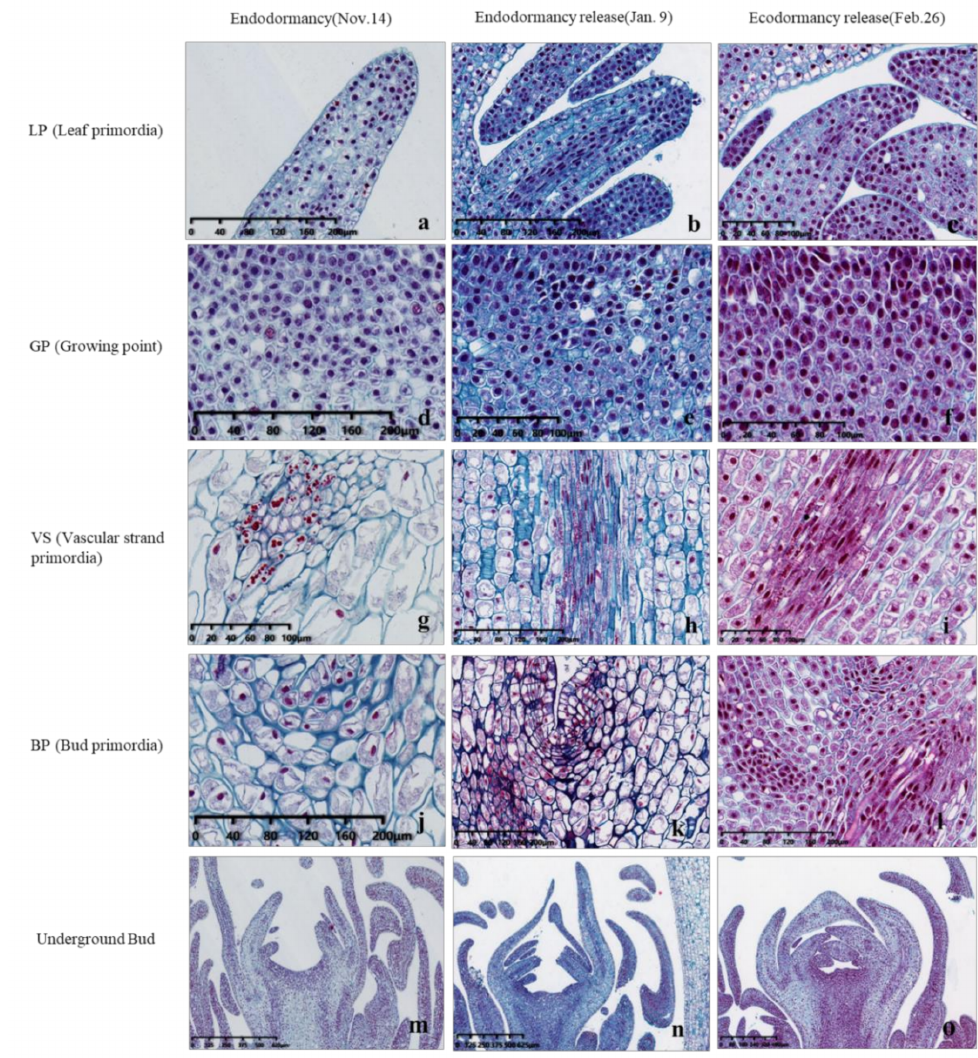
Figure 4. Cytological observation of ‘Meiju’ underground buds from endodormancy to ecodormancy. The dyeing method in the picture is as follows: Safranin O-Fast Green staining. ( a – c ): Leaf primordia; ( d – f ): Growing point; ( g – i ): Vascular strand primordia; ( j – l ): Bud primordia; m-o: Underground bud. The scale bars are in the lower left corner of the